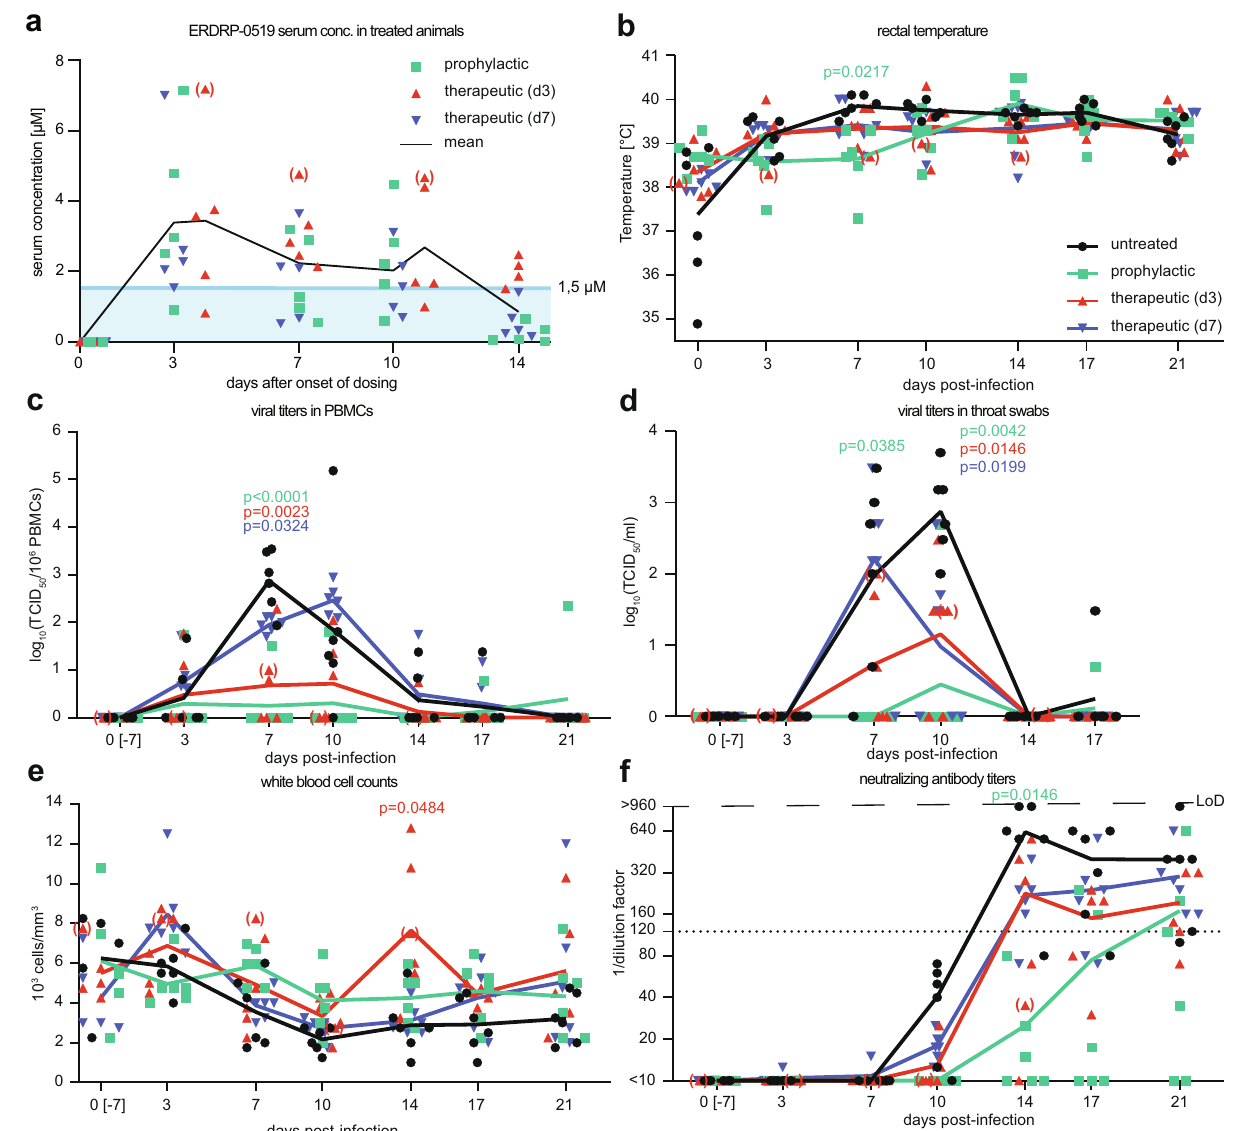
Fig. 3 Clinical parameters of MeV infection in squirrel monkeys. a Trough serum concentrations of ERDRP-0519 in infected squirrel monkeys ( n = 15) participating in this study followed over a 14-day b.i.d. oral treatment period. Solid black line shows mean values; blue line and square show the constant drug concentration (1.5 μ M) applied in the ex vivo steady-state recapitulation to assess anti-MeV activity in hPBMCs shown in Fig. 1e. b Rectal temperature measured in the morning. c , d PBMC and throat swab titers, determined by end point dilution assay and expressed as log 10 (TCID 50 /10 6 PBMCs) or log 10 (TCID 50 /ml) throat swab suspension, respectively. e White blood cell counts from whole blood, expressed as 10 3 cells/mm³. f Neutralizing antibody titers, expressed as reciprocals of the highest serum dilution showing no signs of infection. Dotted line represents the expected protective antibody titer. LoD limit of detection. The day 0 blood samples and swabs were collected 7 days before the start of the experiment (0[-7] days post-infection). Statistical analysis with two-way ANOVA with Dunnett ’ s multiple comparisons post-hoc test was applied in b – f , using the untreated group as reference. Signi fi cant p values ( p < 0.05) are shown, color-coded by group. For a n = 5 for all groups, for b – f n = 6 for all groups, except n = 5 for the 17 and 21 dpi time points in the therapeutic d3 group and n = 5 for the 0 dpi time points for Fig. 3e. Deceased animal is illustrated in parenthesis in all sub-panels; therapeutic (d3)